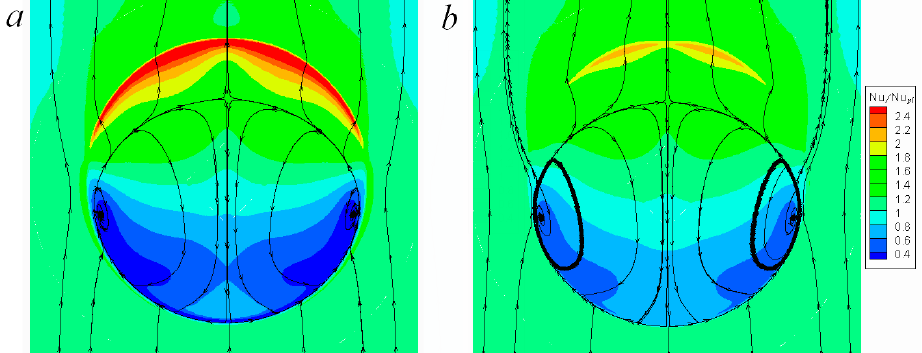
Figure 7. Calculated relative Nusselt number fields near the spherical dimple at the heated wall of the narrow channel at different boundary conditions and the streamlines: ( a )— T = const; ( b )— q = const.